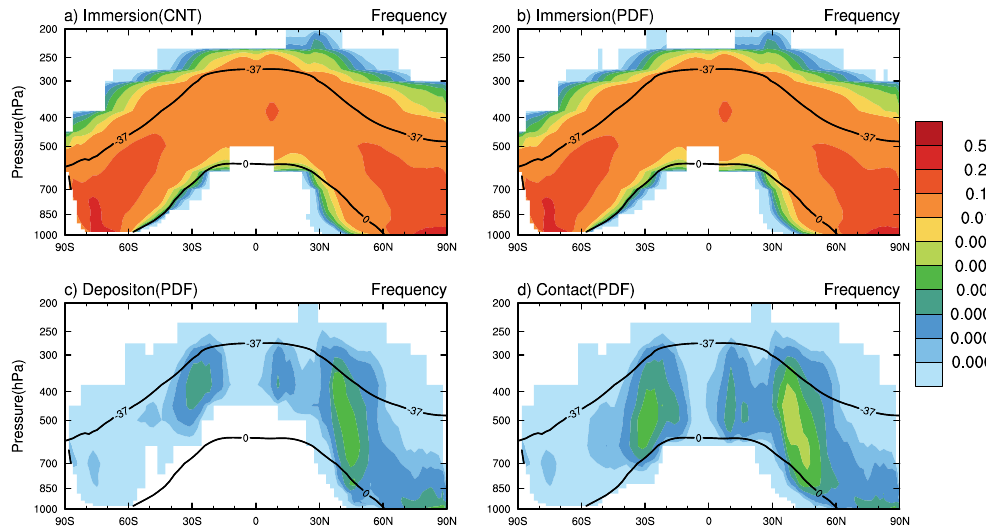
Figure 9. Zonal and annual mean distribution of the occurrence frequency of (a) immersion mode in the CNT simulation and (b) immersion, (c) deposition and (d) contact freezing modes in the PDF simulation. Isotherms of 0 ◦ C and − 37 ◦ C are plotted.